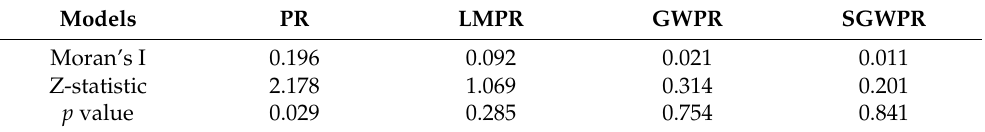
Table 6. Global Moran’s I, Z-statistic, and p value statistical analysis results of the four models. Models